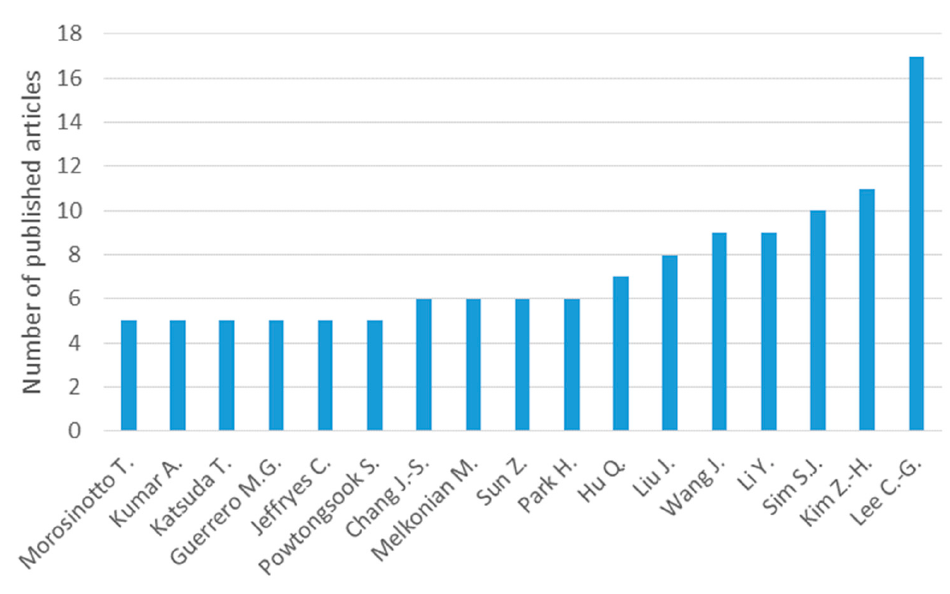
Figure 4. The most productive authors (min. 5 articles).